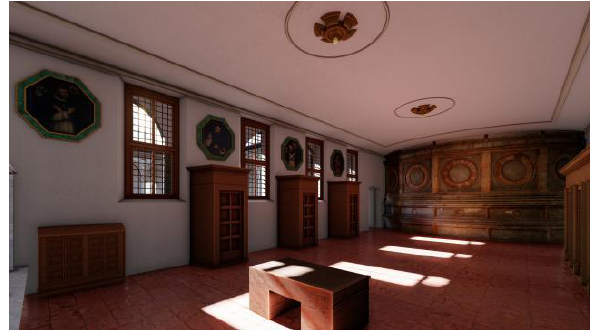
Figure 13. VR experience: The New Sacristy.